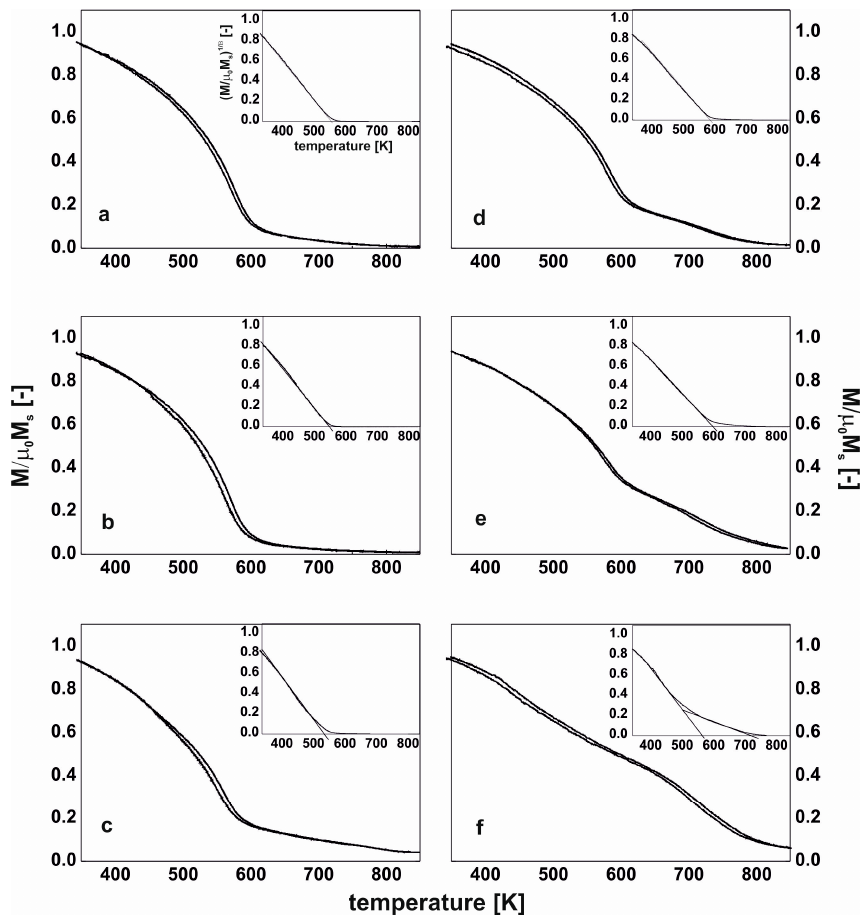
Figure 6. The magnetic saturation polarization curves for the alloys in the as-cast state ( a – c ) and after the thermal treatment at 940 K for 10 min ( d – f ) made by the suction-casting method: Fe 61 Co 10 W 1 Y 8 B 20 ( a , d ), Fe 62 Co 9 W 1 Y 8 B 20 ,( b , e ), Fe 63 Co 8 W 1 Y 8 B 20 ( c , f ).